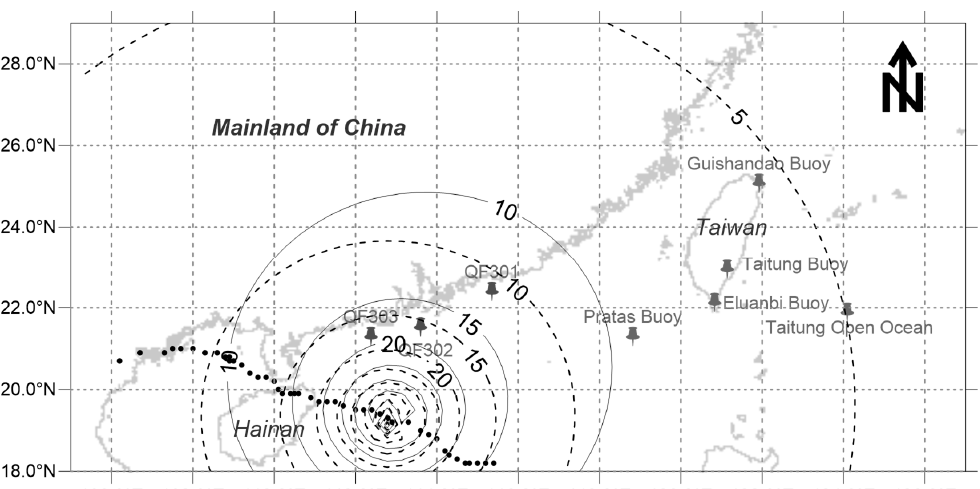
Figure 10. Wind fields (unit: m/s) restructured by MH10 (asymmetric structure as solid line, B3-A1-A2) and the model with a varying parameter b but without an asymmetric structure (B3-A1-A1) at QF301 Station peak wave time during Typhoon Nesat (172011).